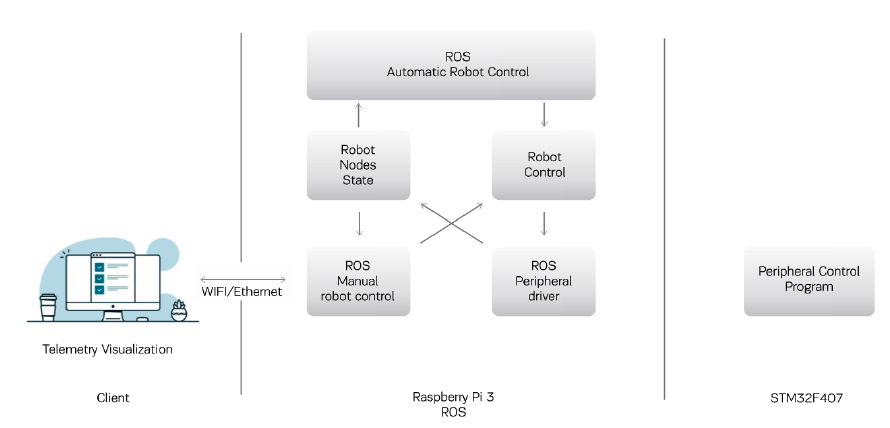
Figure 3. Functional diagram of the tasks and data distribution.